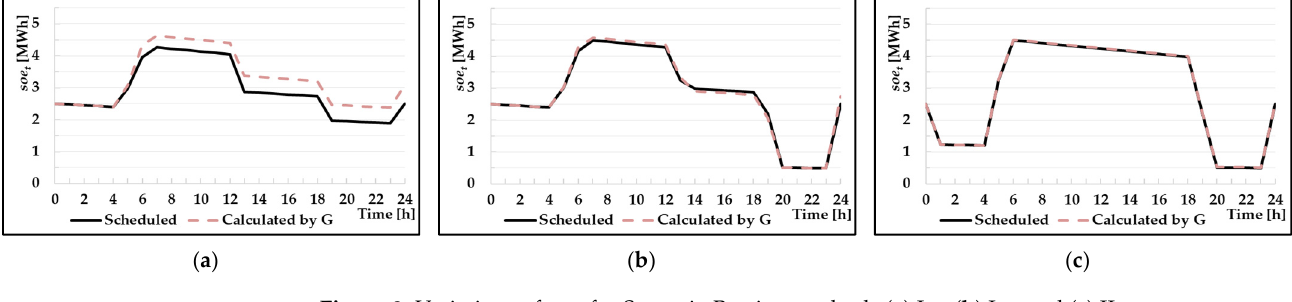
Figure 7. Charging/discharging patterns for Scenario A using methods ( a ) I 70, ( b ) I 80 , and ( c ) II. Figure 8. Variations of soe t for Scenario B using methods ( a ) I 70 , ( b ) I 80 , and ( c ) Figure 8. Variations of Case I 80 –B is similar to the actual value of